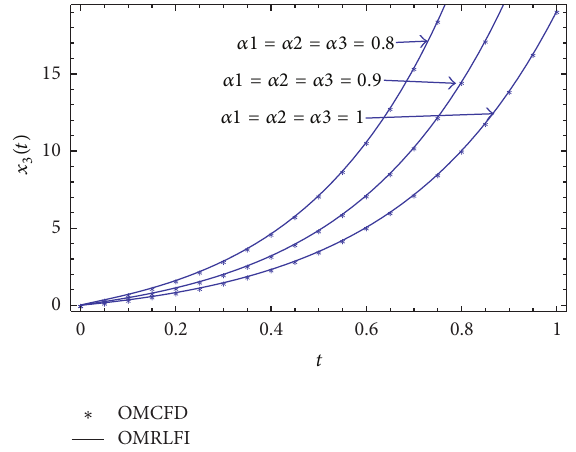
Figure 11: Approximate solutions of 𝑥 3 (𝑡) for 𝑚 = 10 and different values of 𝛼 1 , 𝛼 2 , 𝛼 3 by OMCFD and OMRLFI in Example